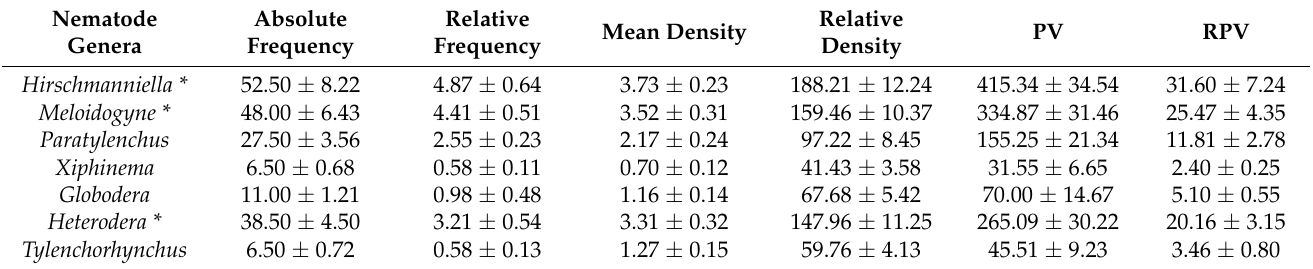
Figure 8. The nematode genera are found in the rice root samples during crop plantation (summer season) in the rice fields. ( a ) The abundance of root-nematode genera, where bars represent the mean of 72 rice root samples ( ± SD) and different letters on the bars show the significance at p ≤ 0.05 among the different nematode genera; ( b ) frequency and density relation of root nematodes in the rice fields; ( c ) root-knot infection by nematodes; ( d ) cyst formation by root nematodes; and ( e ) lesion formation by root nematodes. Table 3. The absolute and relative frequency, mean and relative density and prominence value and relative prominence value of plant-parasitic nematode genera found in rice root